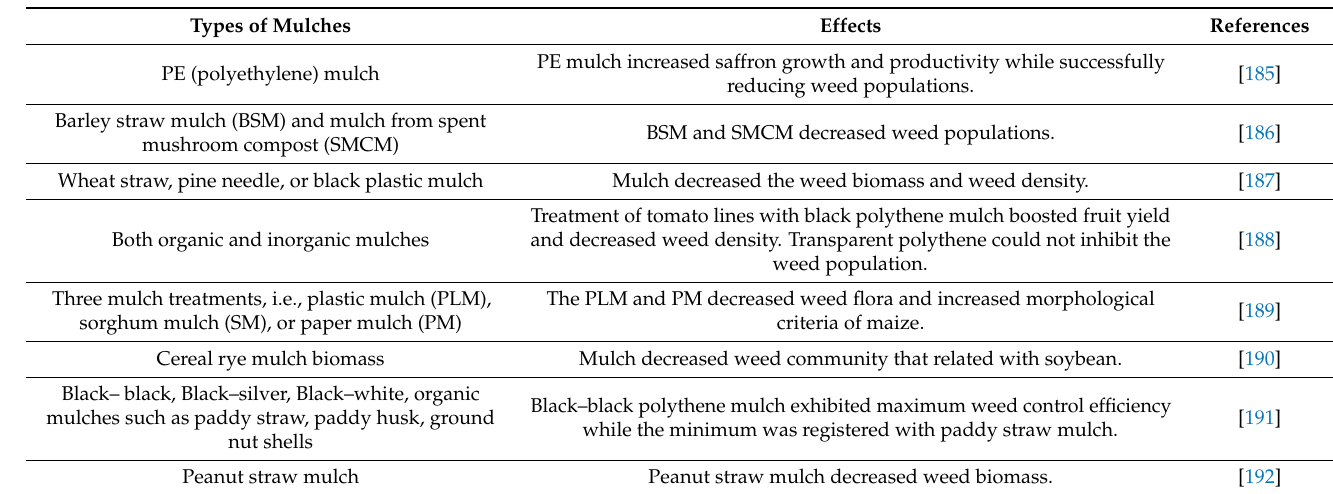
Table 4. The impact of different mulches on weed